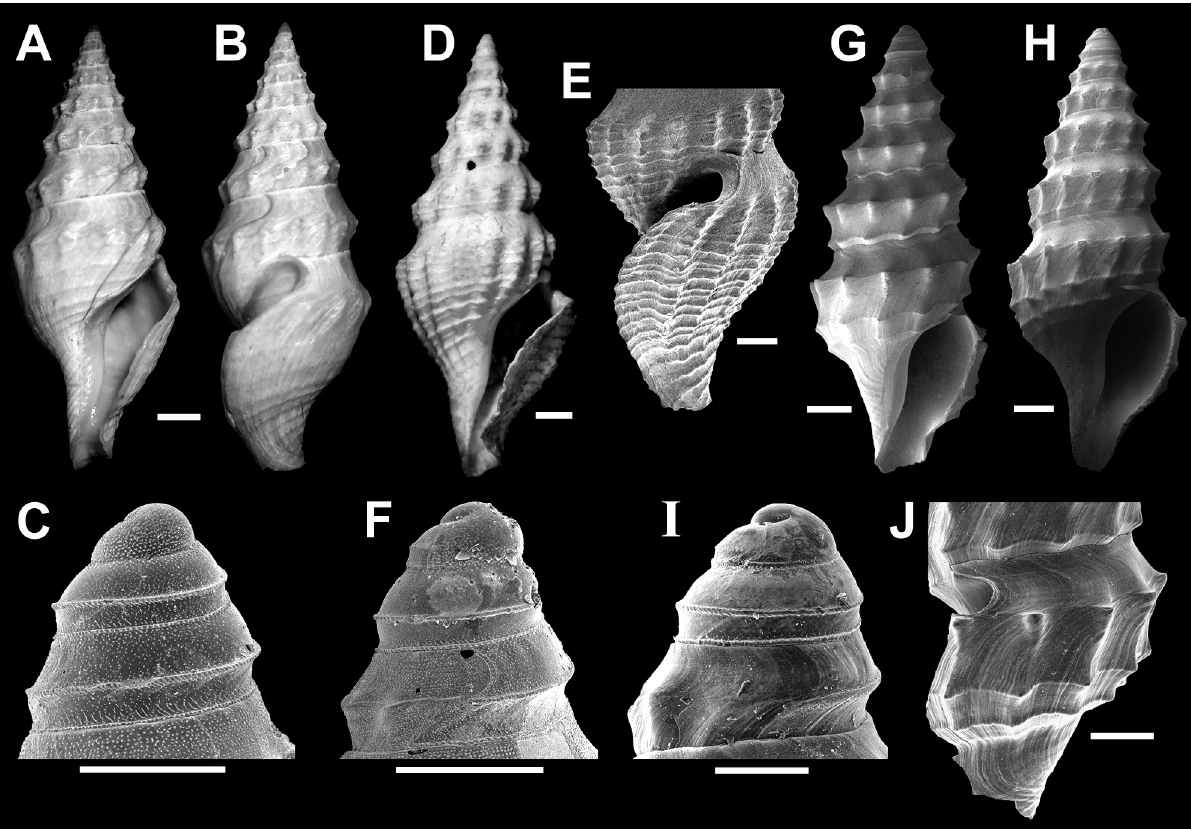
Fig . 2. – A-C, Corinnaeturris leucomata (Dall, 1881): A, B, IBUFRJ 16616, 20.9 mm, whole shell; C, IBUFRJ 18236, 2.82 mm, protoconch; D-F, Corinnaeturris rhysa (Watson, 1881): D, IBUFRJ 17052, 12.2 mm, whole shell; E, F, IBUFRJ 18234, 14.2 mm; E, labial sinus; F, protoconch; G-J, Corinnaeturris angularis n.sp.: G, I, J, Holotype, IBUFRJ 17053, 5.74 mm; G, whole shell; I, protoconch; J, labial sinus; H, paratype, MCZ 362500, 6 mm, whole shell. Scale bars: A, B = 2 mm; D, E = 1 mm; C, F, G, H, I, J = 500